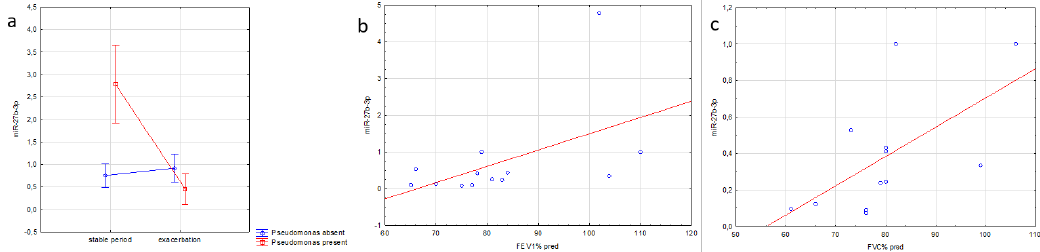
Figure 4. Association of miR-27b expression and clinical parameters in CF patients, ( a ) in sputum correlation with Pseudomonas infection during exacerbation (F = 25.267, p < 0.001, 2-way analysis of variance); ( b ) in EBC correlation with FEV1 (r = 0.510; p = 0.077) and ( c ) FVC (r = 0611; p = 0.034) during